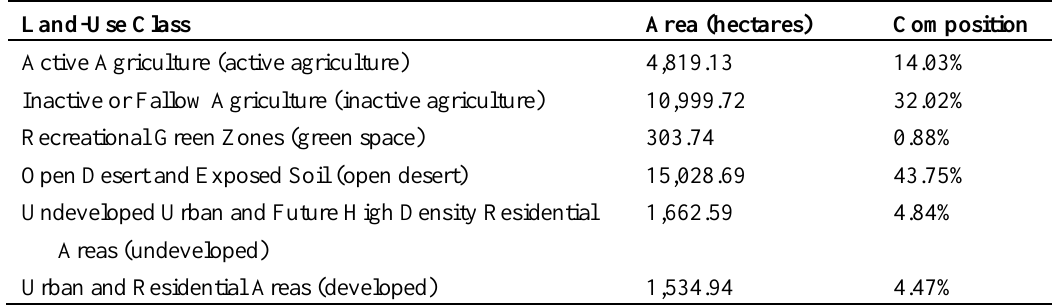
Table 6. OBIA land-use area and